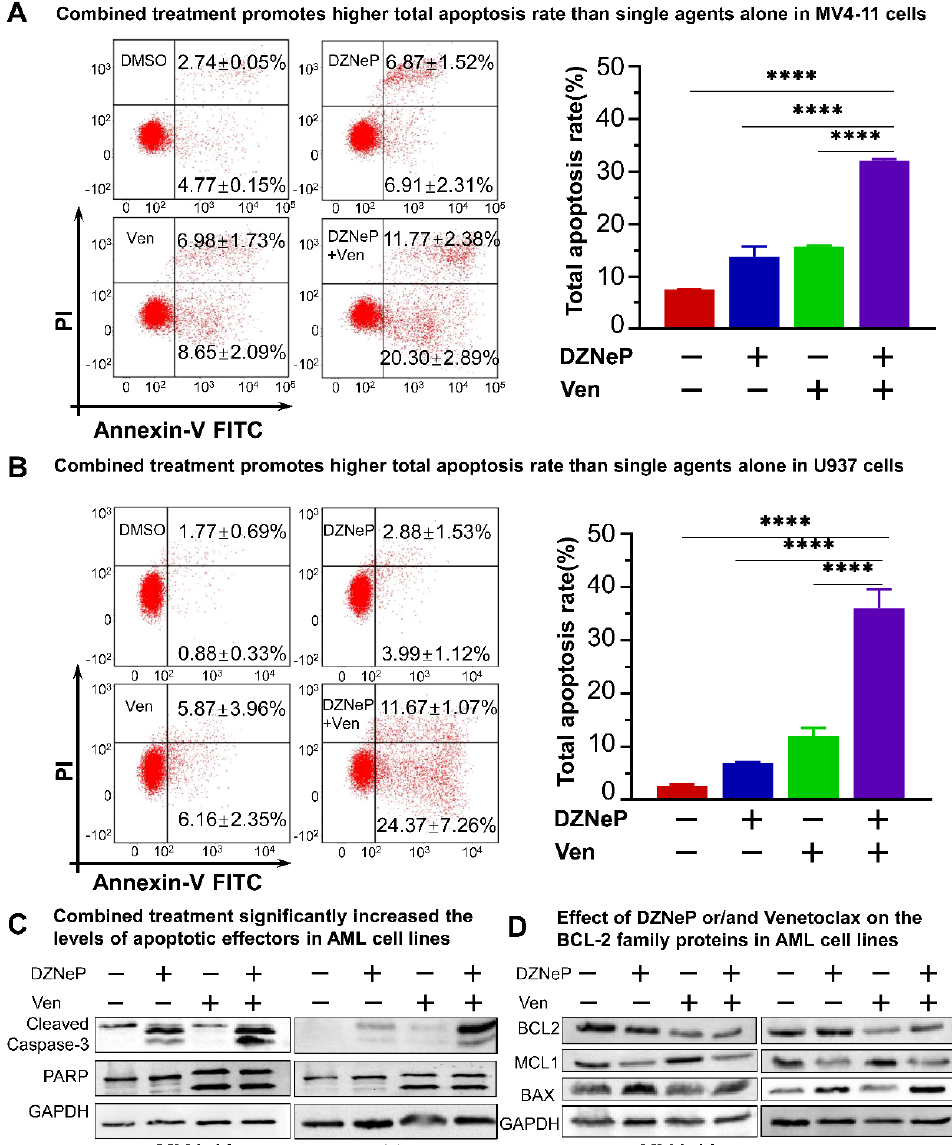
Figure 2. Synergistic effects of DZNeP with Ven on apoptosis in AML cells. ( A , B ) Effects of DZNeP (1 μ M), Ven (8 nM for MV4-11 and 8 μ M for U937, respectively), and the combination of DZNeP (1 μ M) plus Ven (8 nM for MV4-11 and 8 μ M for U937, respectively) on apoptosis in MV4-11 ( A ) and U937 cells ( B ). Cells were treated for 48 hrs and were stained with PI and annexin V FITC for flow cytometry analysis. The percentage of the total apoptosis rate is calculated with the early apoptotic plus the late apoptotic proportion. Mean ± SD of triplicates is representative of independent experiments. ****, p < 0.0001. ( C ) Western blot analysis of the apoptotic effectors, cleaved caspase-3 and PARP, in MV4-11 and U937 cells following the treatment of the indicated drugs for 48 hrs. GAPDH was used as a loading control. ( D ) Western blot showing the expression of the BCL-2 family members (BCL-2, MCL1, and BAX) in MV4-11 and U937 cells treated with the indicated drugs for 48 hrs. GAPDH was used as a loading control.